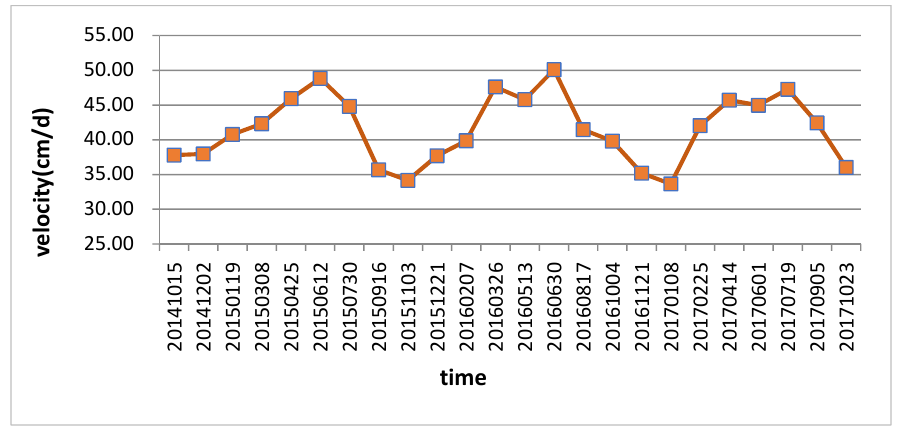
Figure 5. Variation, in time, of average surface velocity of Yiga Glacier.